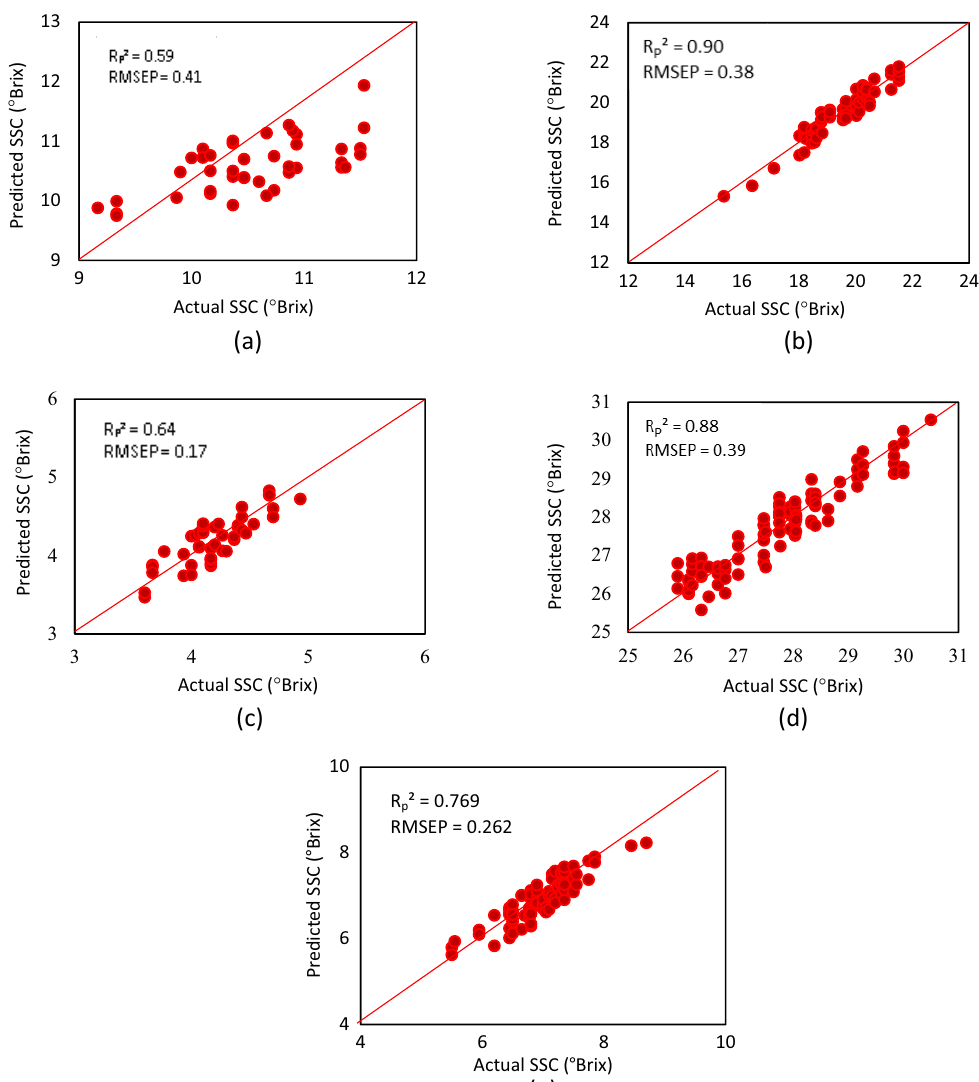
Figure 4: Scatter plots between actual SSC versus Vis – NIR - predicted SSC values of validation sets: ( a ) dragon fruit, ( b ) sapodilla, ( c ) tomato, ( d ) banana, and ( e )